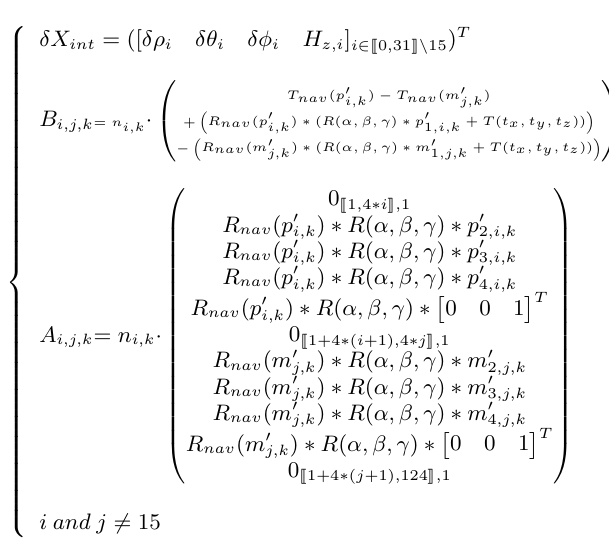
Figure 3. Description of the intrinsic parameters for the Velodyne sensor